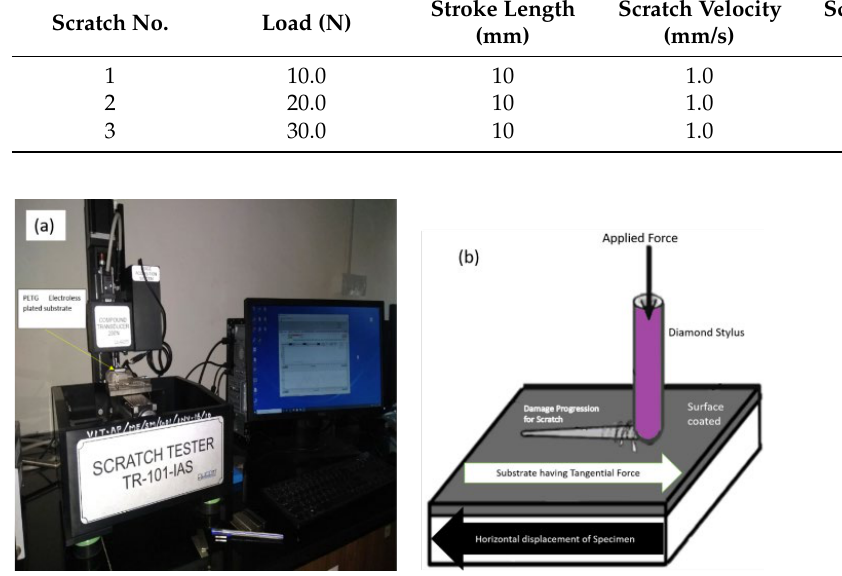
Figure 6. ( a ) Scratch adhesion test machine, ( b ) schematic view.